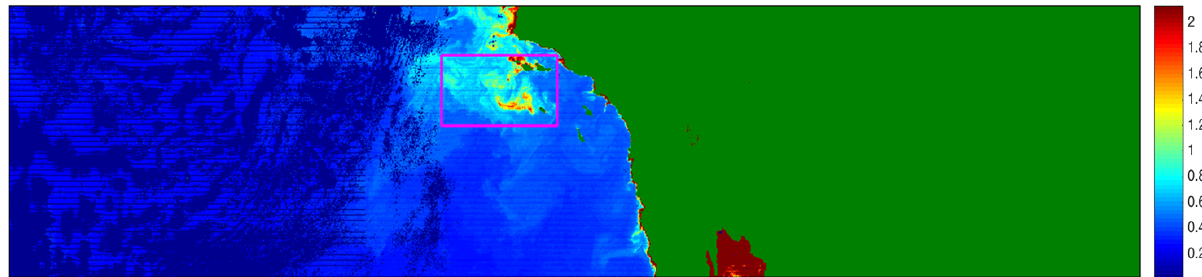
Figure 6. The image shows the chlorophyll concentration in milligrams per cubic meter near the Santa Monica region in southern California as viewed by VIIRS on 7 November 2014. Green represents the land and dark blue represents the dropped data due to bow-tie effects and missing data due to clouds. For a detailed discussion, we next consider the subset of the image that is covered by the pink square in the image.